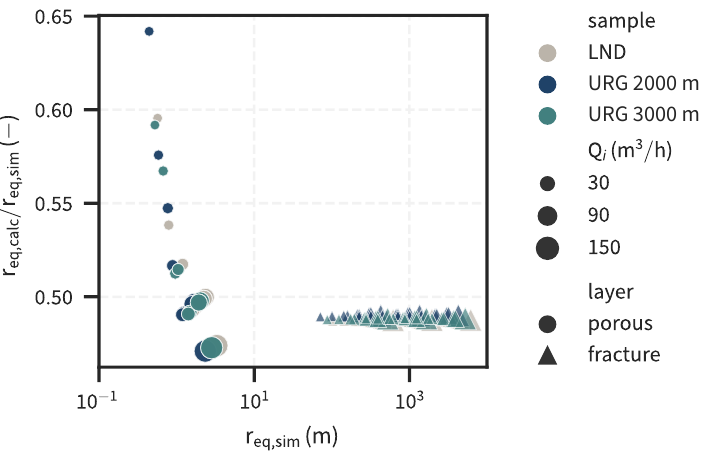
Figure 4. Previously calculated ( r eq,calc , Equation (11)) and simulated equilibrium lengths ( r eq,sim ) are correlated. r eq,calc can thus be used as a predictive parameter. Q i refers to the flow rate of the respective porous or fractured